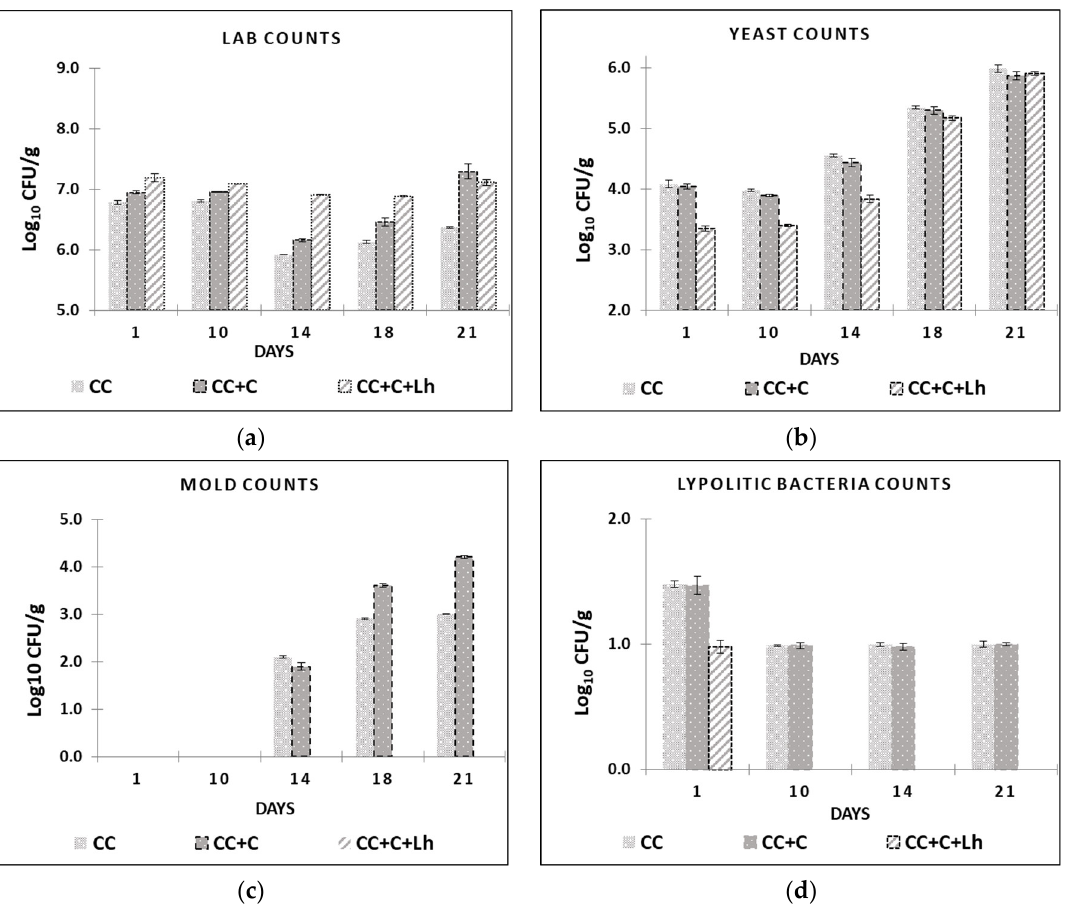
Figure 3. Lactic acid bacteria (LAB) ( a ), yeast ( b ), and mould ( c ) counts and lipolytic bacteria ( d ), are presented for control acid-curd cheese (CC), coated acid-curd cheese (CC + C), and coated acid-curd cheese with L. helveticus (CC + C + Lh) during 23 days of storage at 4–6 °C (mean values ± SD). The concentration of lactic acid (g/100 g) is presented in Figure 2d. At day 1, the concentration of lactic acid in fresh control curd cheeses (CC) was higher (2.15± 0.11; p < 0.05) compared with coated CC + C (1.52 ± 0.01) and CC + C + Lh (1.52 ± 0.02) samples; the samples switched places from day 14 with coated samples demonstrating higher ( p < 0.05) lactic acid content compared with the control one, indicating growth of lactic acid bacteria